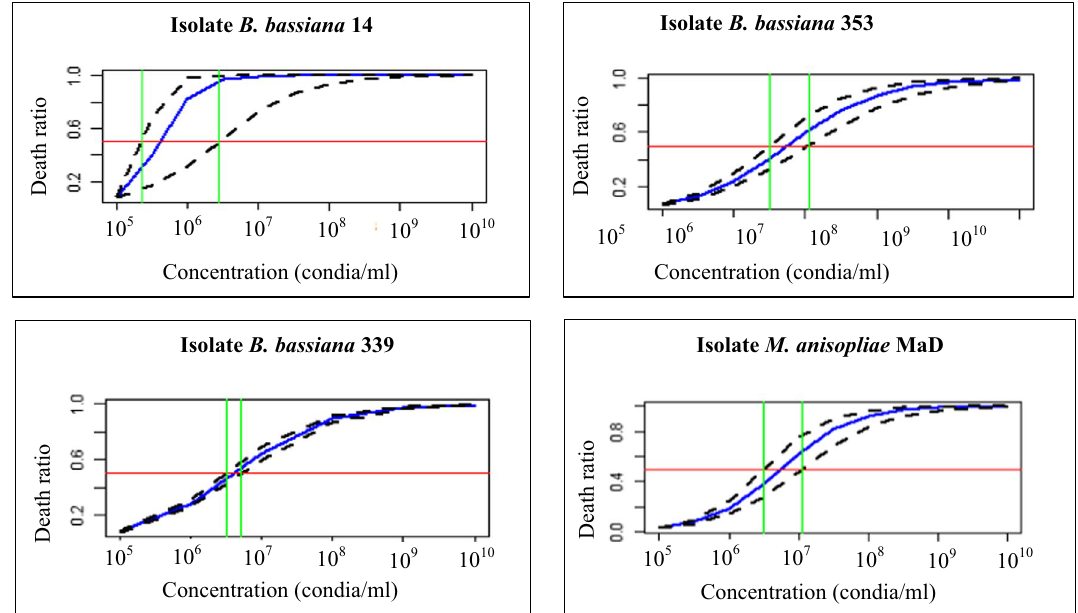
Fig. 11 LC50 values after treatment of larvae of Zeugodacus cucurbitae to various concentrations of Bb14, Bb353, Bb339 and